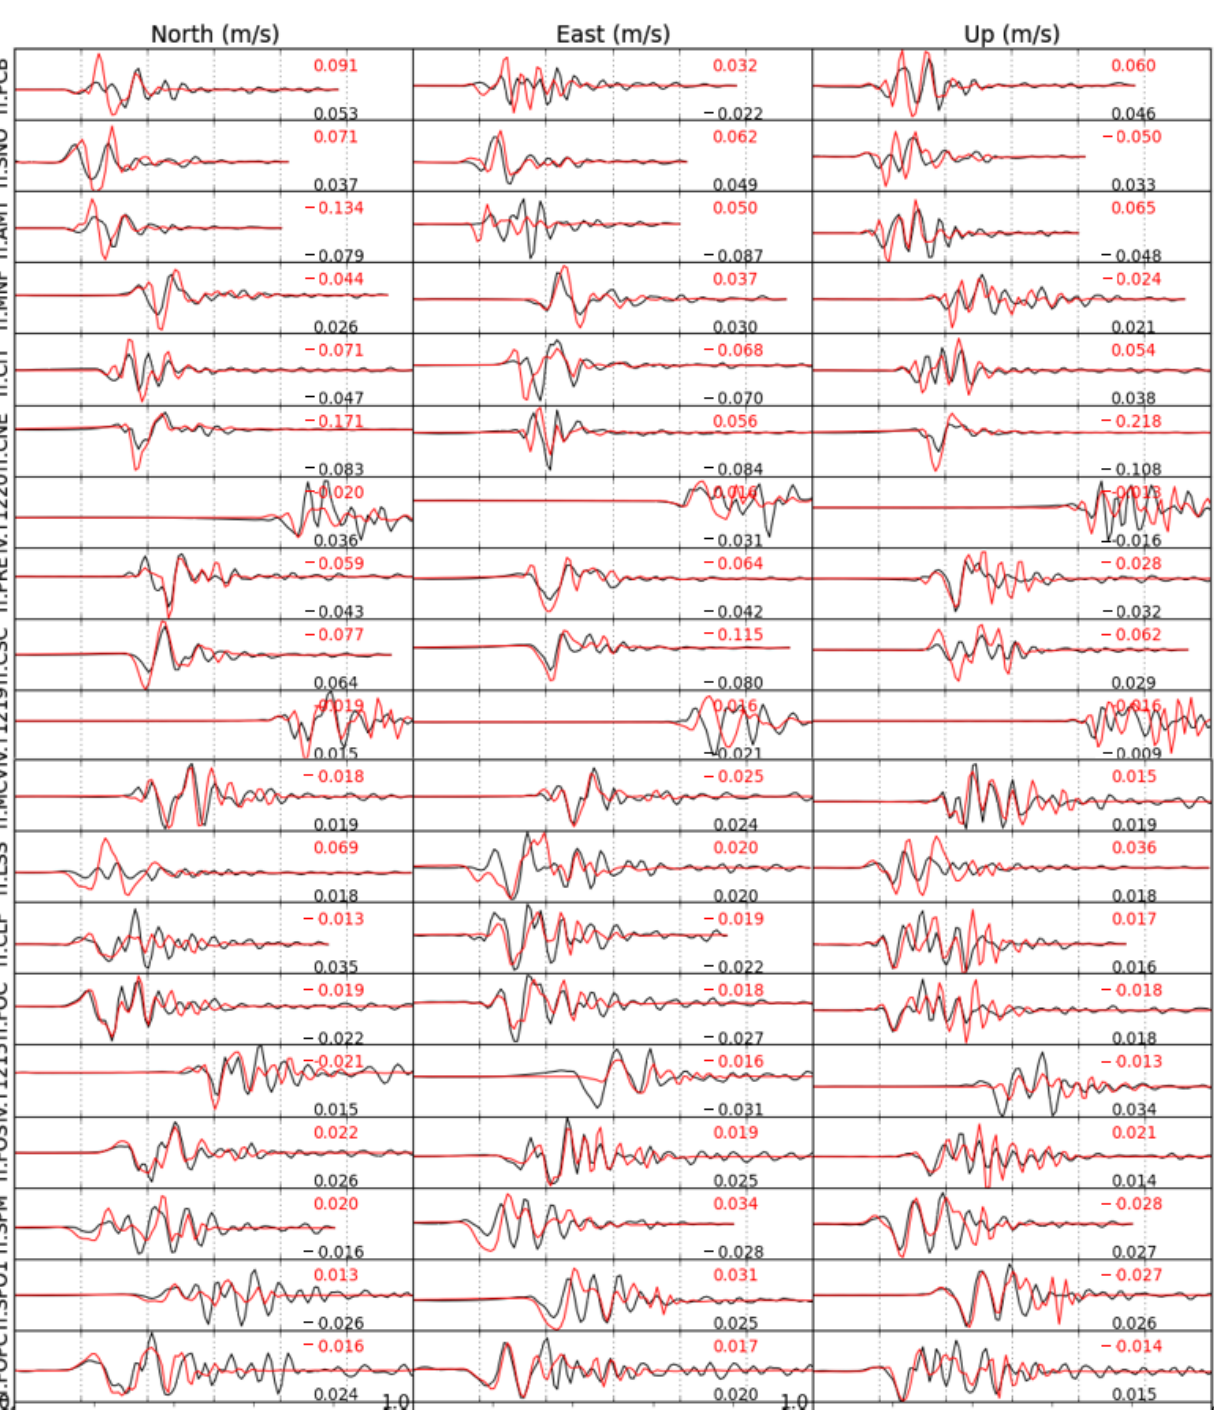
Figure A9. Comparison of strong-motion velocity records (black) and the synthetic seismograms (red) predicted by the joint slip model of the Norcia earthquake.